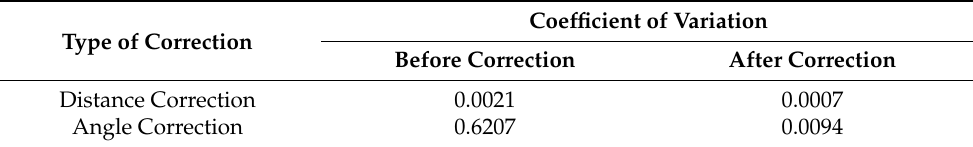
Figure 9. Comparison of original and corrected laser intensity values of the flat target used in the experiments. ( a ) Correction for the distance effect; ( b ) Correction for the incidence angle effect. Table 4. Coefficient of variation of the laser intensity values of the flat target before and after the intensity